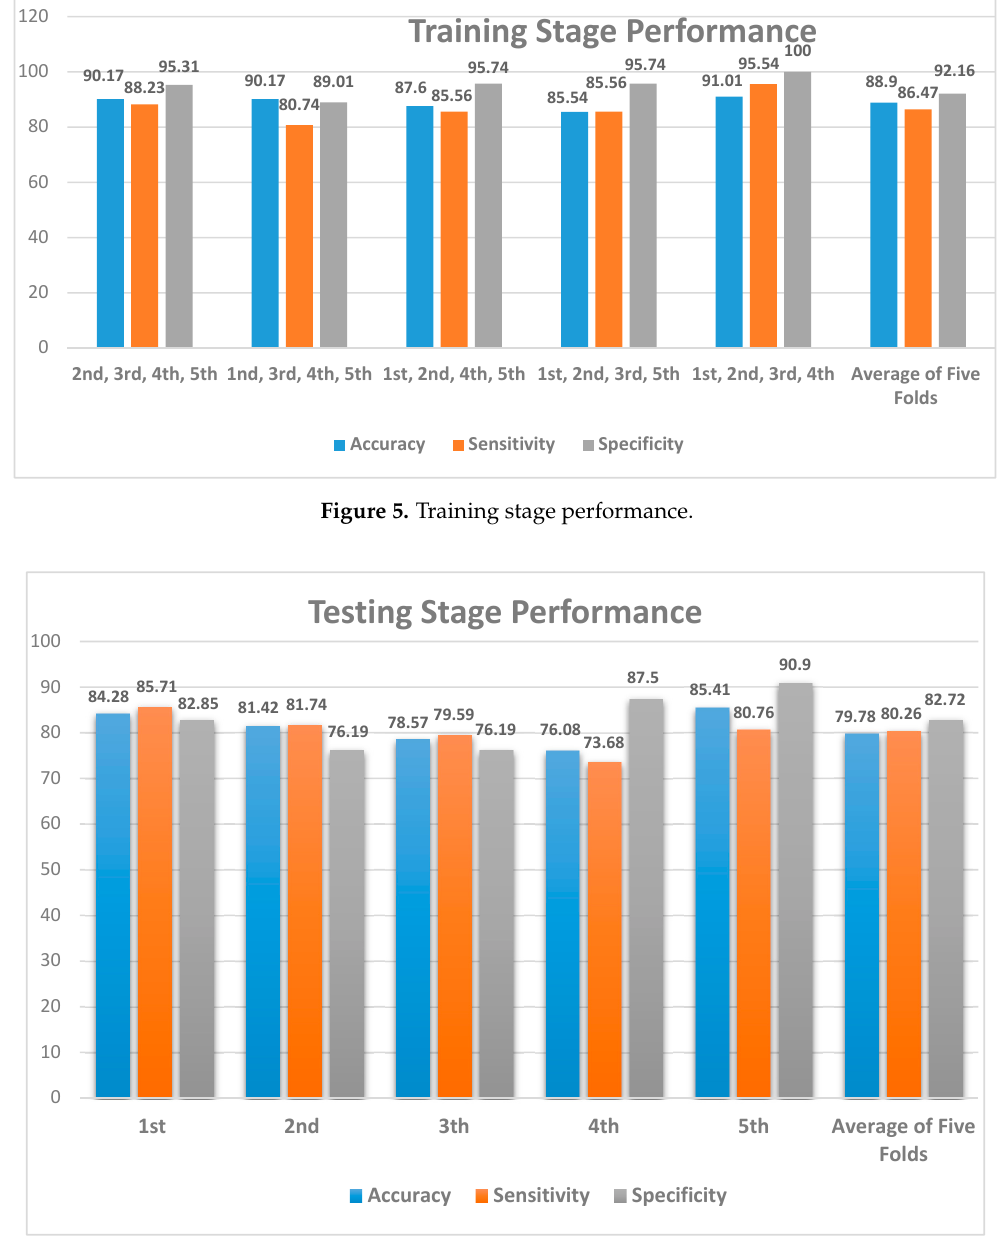
Figure 6. Testing stage performance.